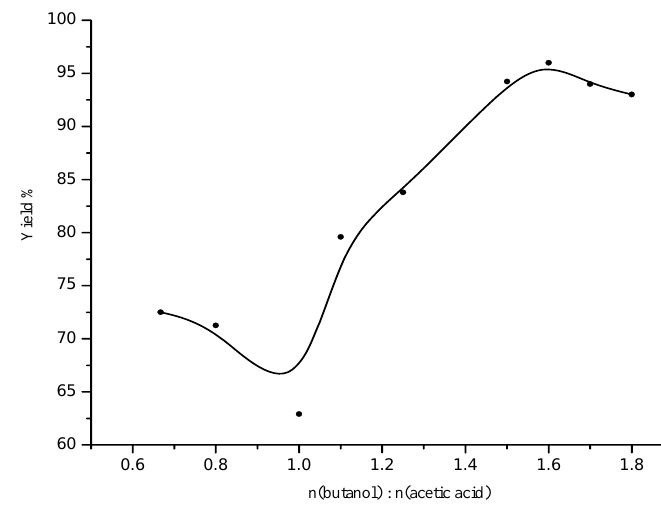
Figure 5. Influence of butanol/acid mole ratio on ester yield.